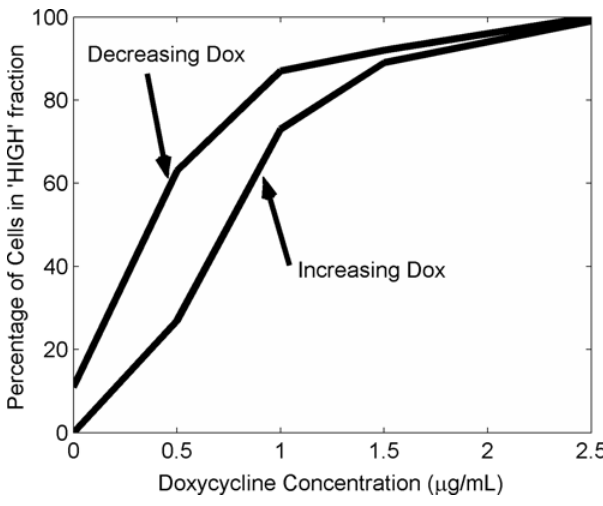
Figure 4. Computer simulations predict hysteretic behaviour. Based on the simulations in Figure 3 and corresponding simulations of the on R off transitions. The lower curve represents the percentage of cells in the ‘HIGH’ expression region as the concentration of Dox is gradually increased. The upper curve shows the percentage of cells in the ‘HIGH’ expression region after a transition from a saturating Dox level to that shown.